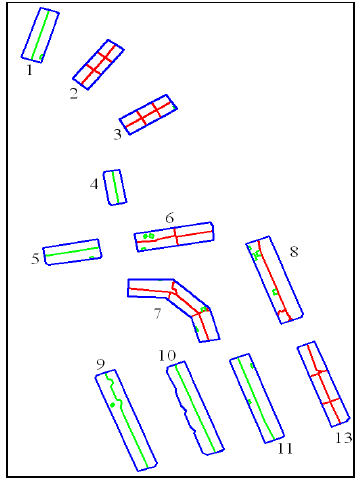
Figure 8. Final result of automatic 2D building modelling; Hermanni site; in blue: the building outlines; in red: the inner roof boundaries; in green: the roof details